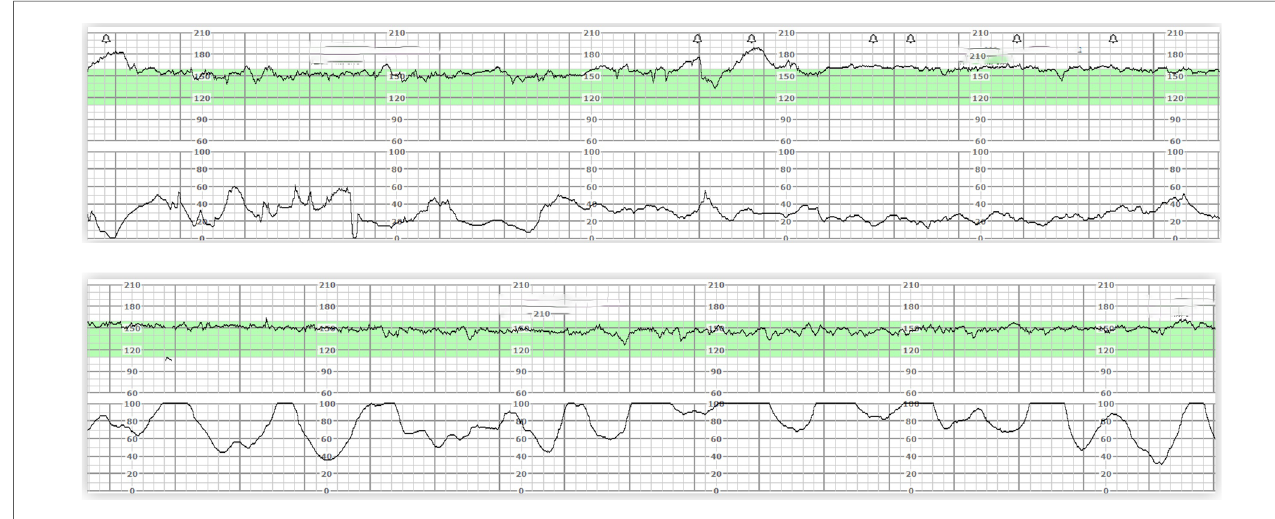
FIGURE 1 Electronic fetal monitor on admission and fetal monitor with